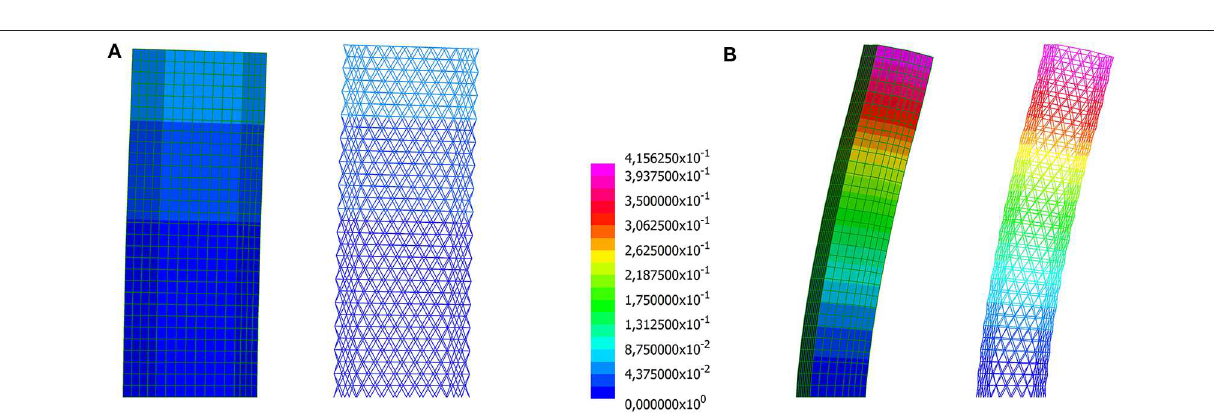
FIGURE 11 | Optimal thickness (mm) in the diagrid of a tall building with hexagonal plan, using four circular hollow cross-sections with φ 32 1 elements, W 92,978kN; (B) patch with 2 × =